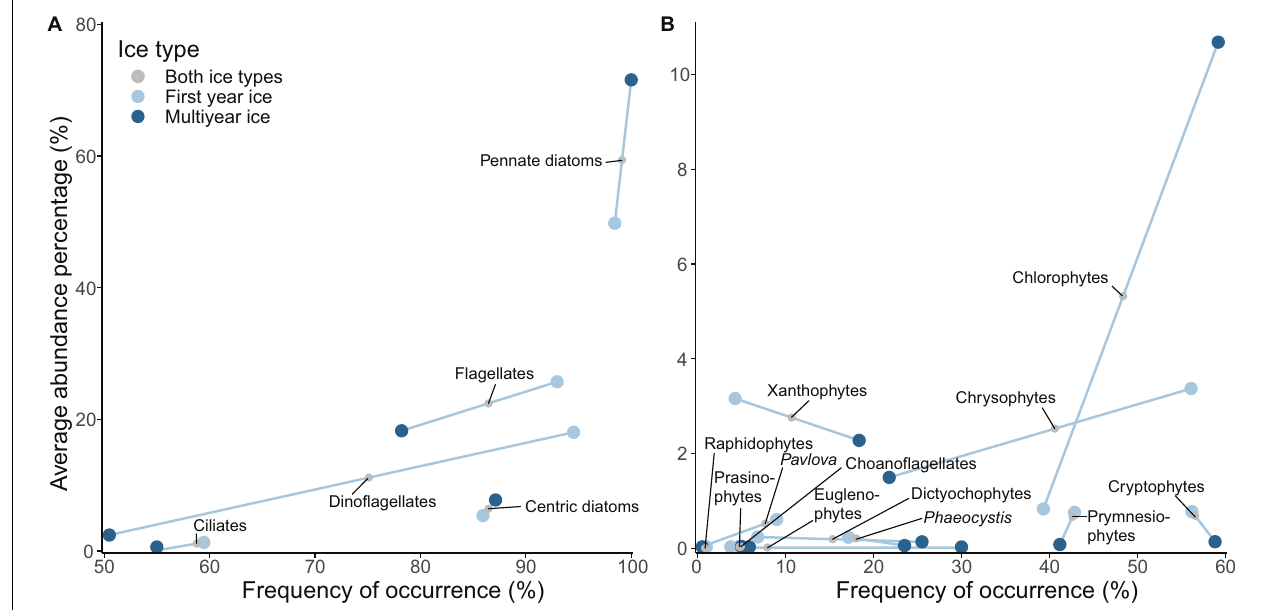
FIGURE 2 | Mean abundance percentage (AP) versus frequency of occurrence (FO) of sea-ice eukaryote groups encountered in the dataset. (A) Coarse taxonomic grouping, (B) Finer taxonomic grouping for identified flagellates. Line separates values for first-year ice (FYI) and multiyear ice (MYI). The effect of a dataset, which systematically did not identify a certain taxon was removed from the AP and FO